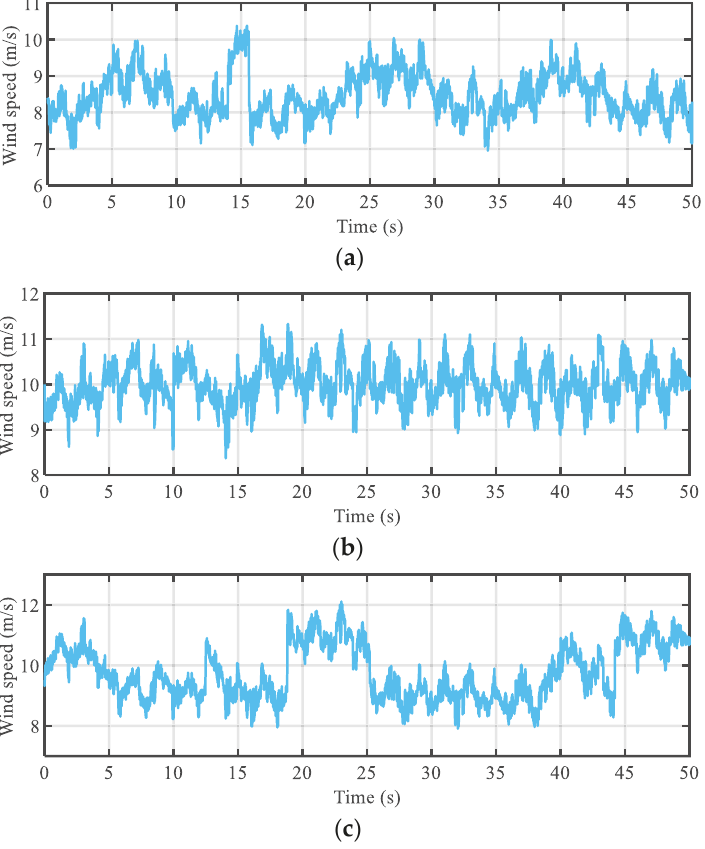
Figure 3. Turbulent wind speed curve: ( a ) mean wind speed of 8.3 m/s with approximately 7.2% turbulence intensity; ( b ) mean wind speed of 10 m/s with approximately 5% turbulence intensity; ( c ) mean wind speed of 10 m/s with approximately 10% turbulence intensity.